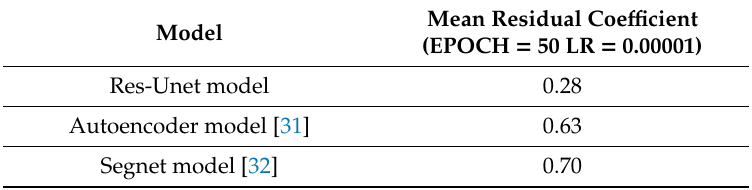
Table 10. The comparison of the mean residual coefficient score with different models.